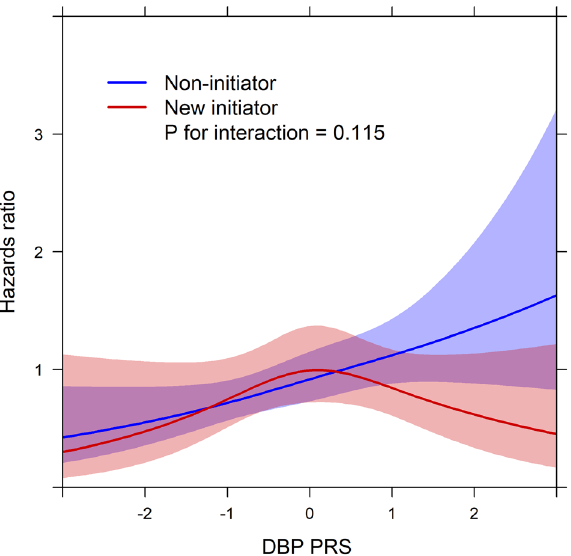
Figure 3. Interaction between diastolic blood pressure polygenic risk score (DBP PRS) and new initiation of antihypertensive medication for liver-related outcomes by time-dependent Cox regression analysis using restricted cubic splines. DBP PRS is standardized as per 1 SD. The light red and light blue areas reflect 95% confidence